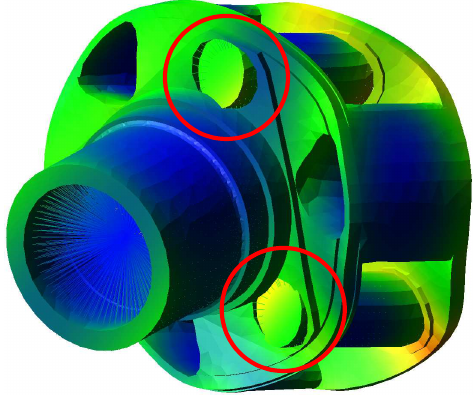
Figure 12: Seventh mode shape of the combined MS and PLC. The planet pins are able to pivot.